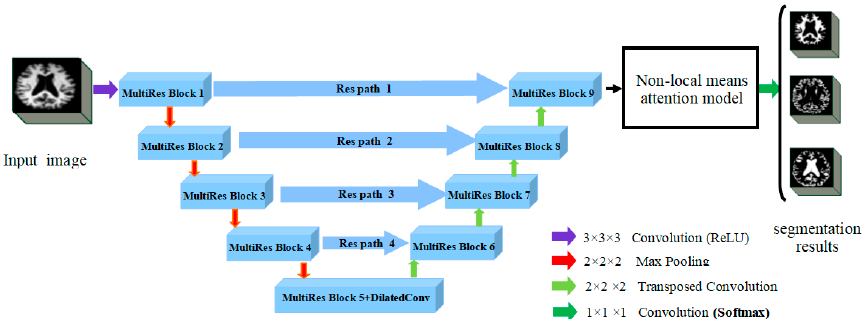
Figure 1. The improved MultiRes + Unet (Reprinted with permission from Ref. [29]. Copyright 2020 Elsevier) algorithm architecture diagram.